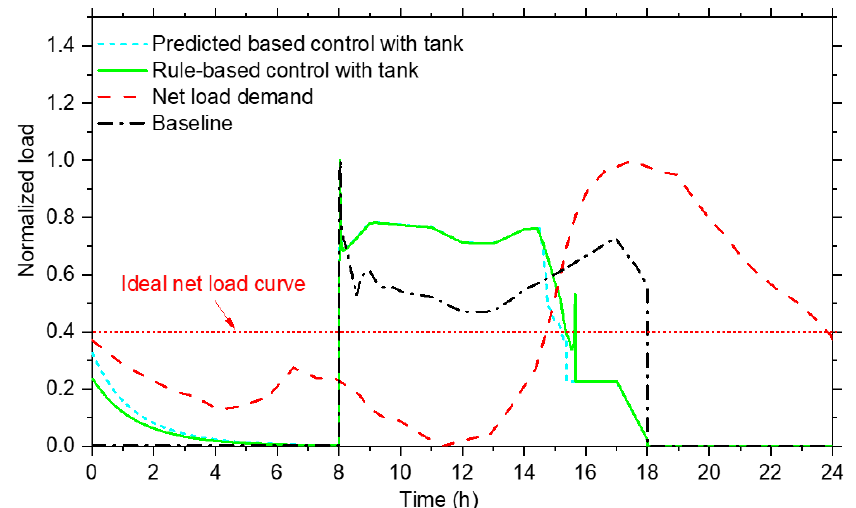
Figure 10. Normalized load curve of rule-based and prediction-based DR control in Scenario 2.